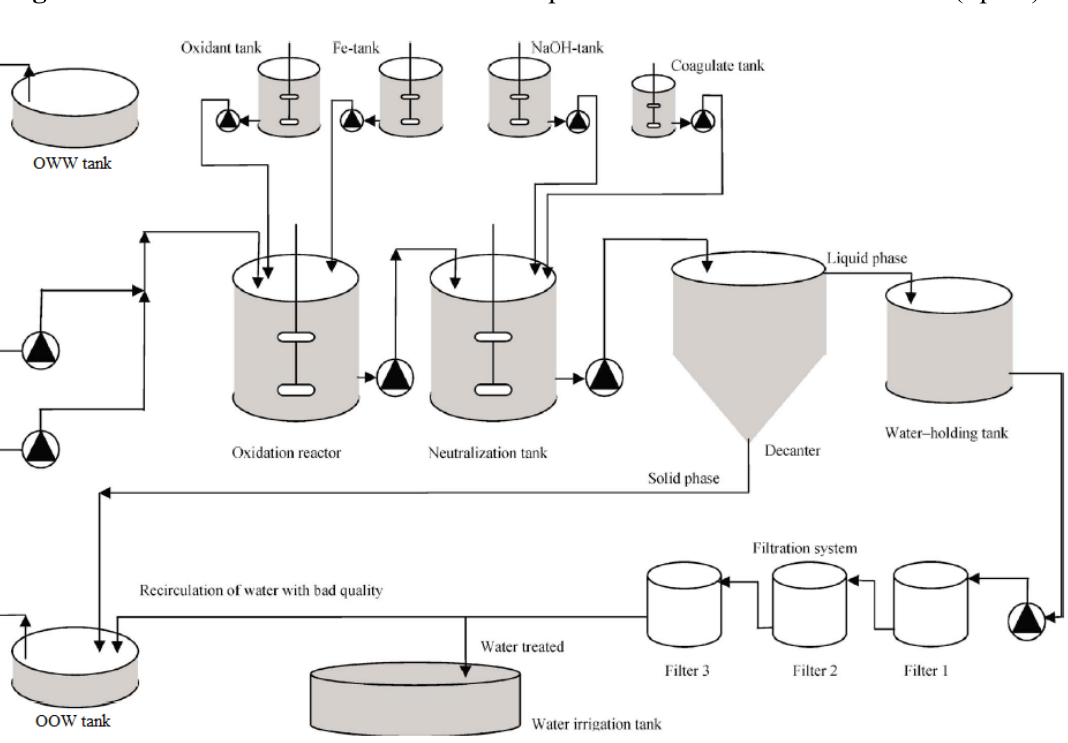
Figure 3. Scheme of the industrial treatment plant for OMW-2 located in Jaén